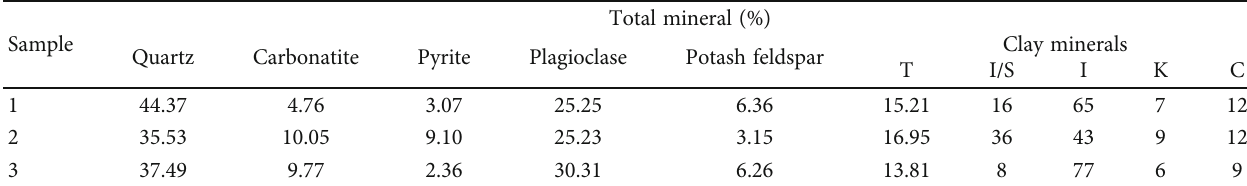
Table 2: Mineral composition characteristics of the samples.